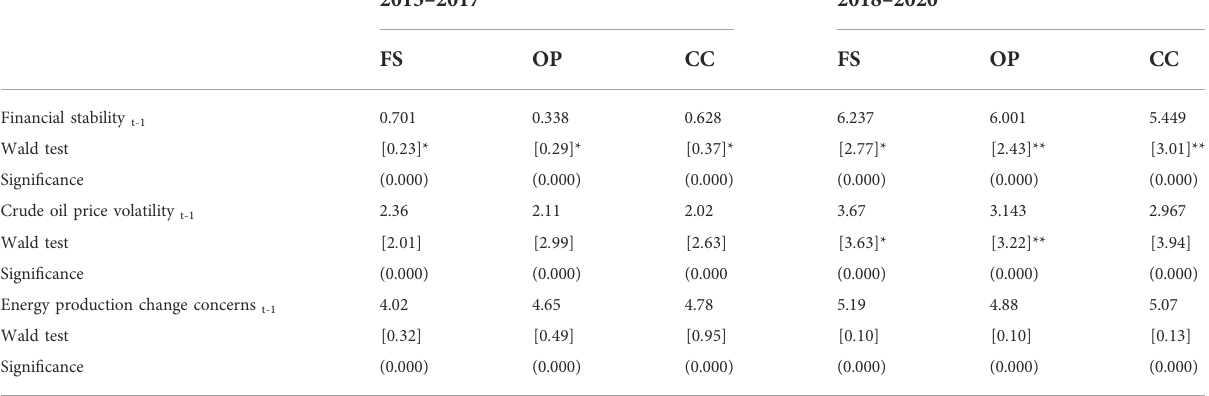
TABLE 4 Sensitivity